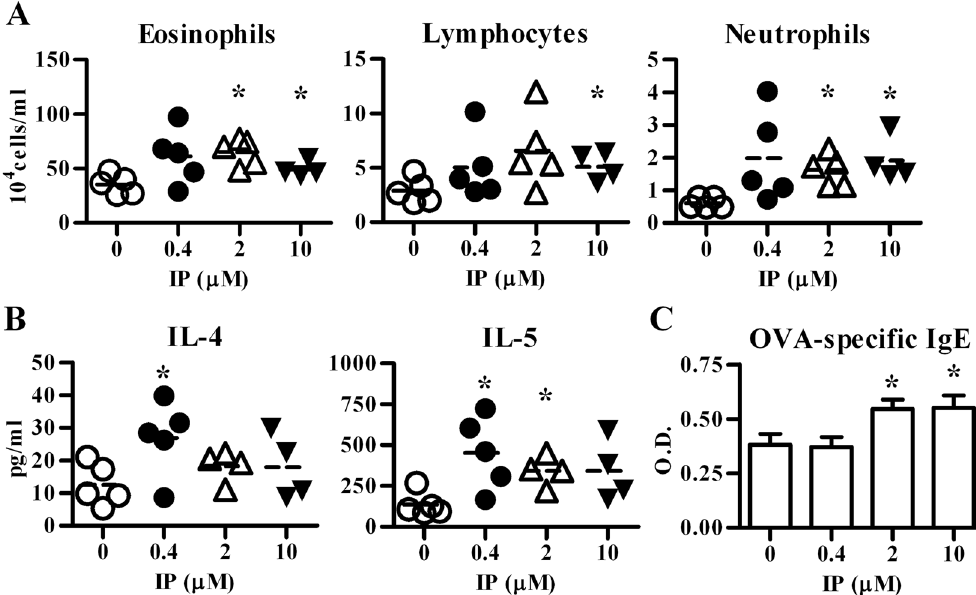
Figure 2. Indeno[1,2,3-cd]pyrene (IP) exposure enhances the severity of allergic lung inflammation in a mild asthmatic murine model. C57BL/6 mice were intranasally exposed to vehicle or various concentrations of IP as indicated and then all immunized and challenged with OVA. Cell subsets ( A ) and cytokine levels ( B ) in BALFs were both determined by flow cytometry. The line within the vertical points marks the mean for each group. ( C ) Serum levels of OVA-specific IgE Abs (mean ± SEM) were measured by ELISA. Data show one of three independent experiments. Eosinophil number, IL-5 and IgE levels showed group differences by one-way ANOVA. * P < 0.05 vs. vehicle-treated group (Mann-Whitney U